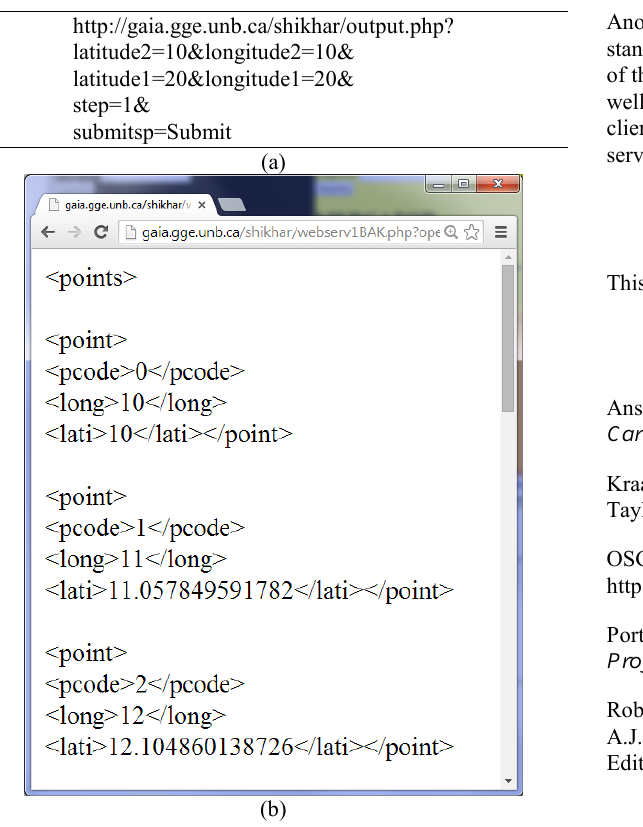
Figure 10. Example query to the web services: (a) shortest path request; and (b) output in XML format.